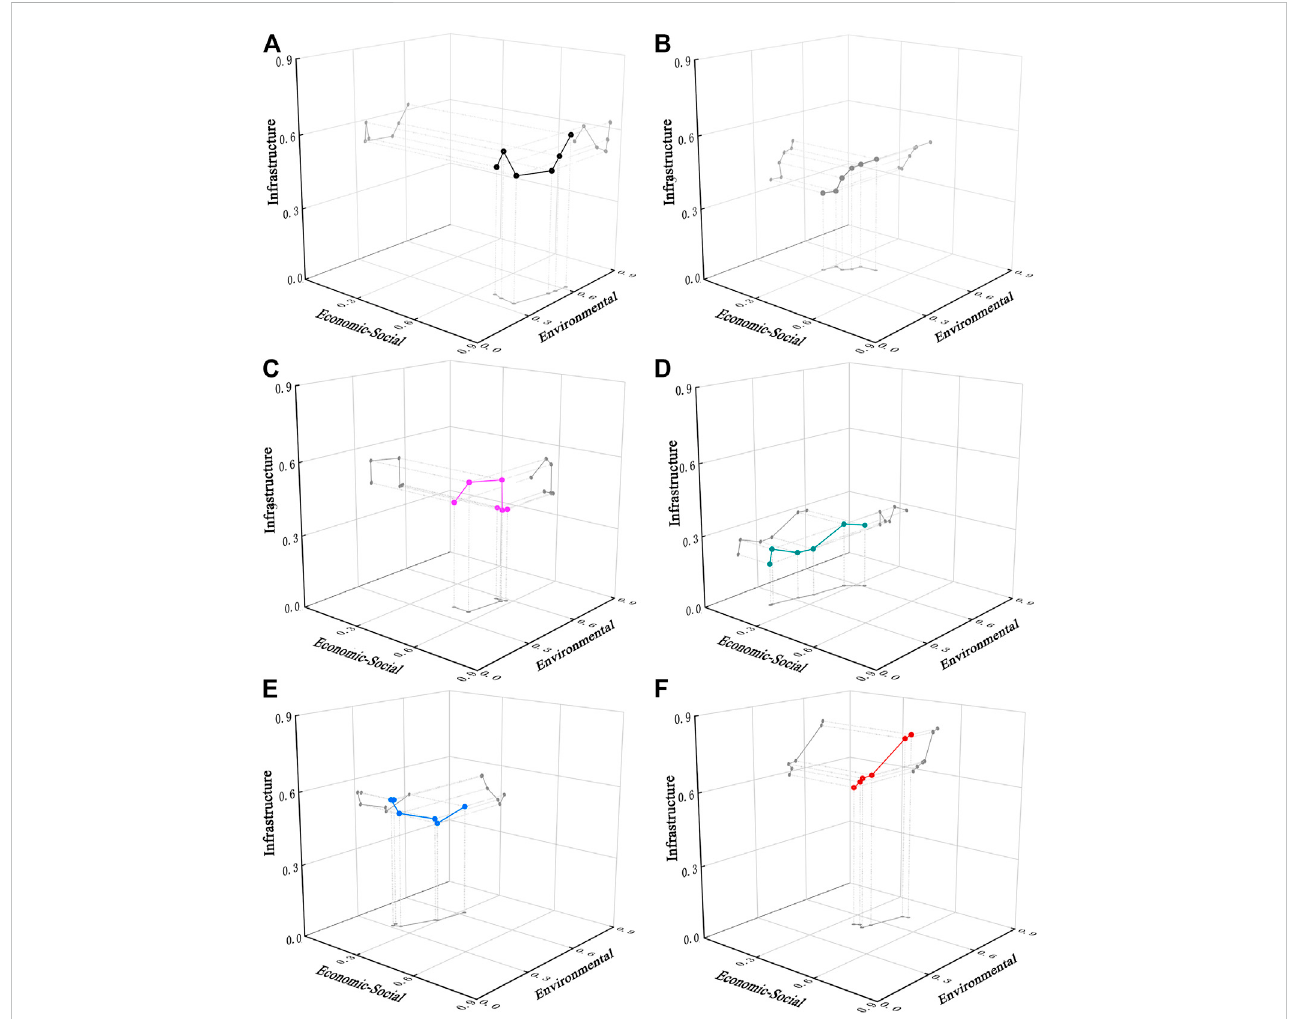
FIGURE 10 Evolutionary paths of urban resilience of each object. (A) Lhasa. (B) Lhoka. (C) Nyingchi. (D) Qamdo. (E) Garzê. (F) Ya ’